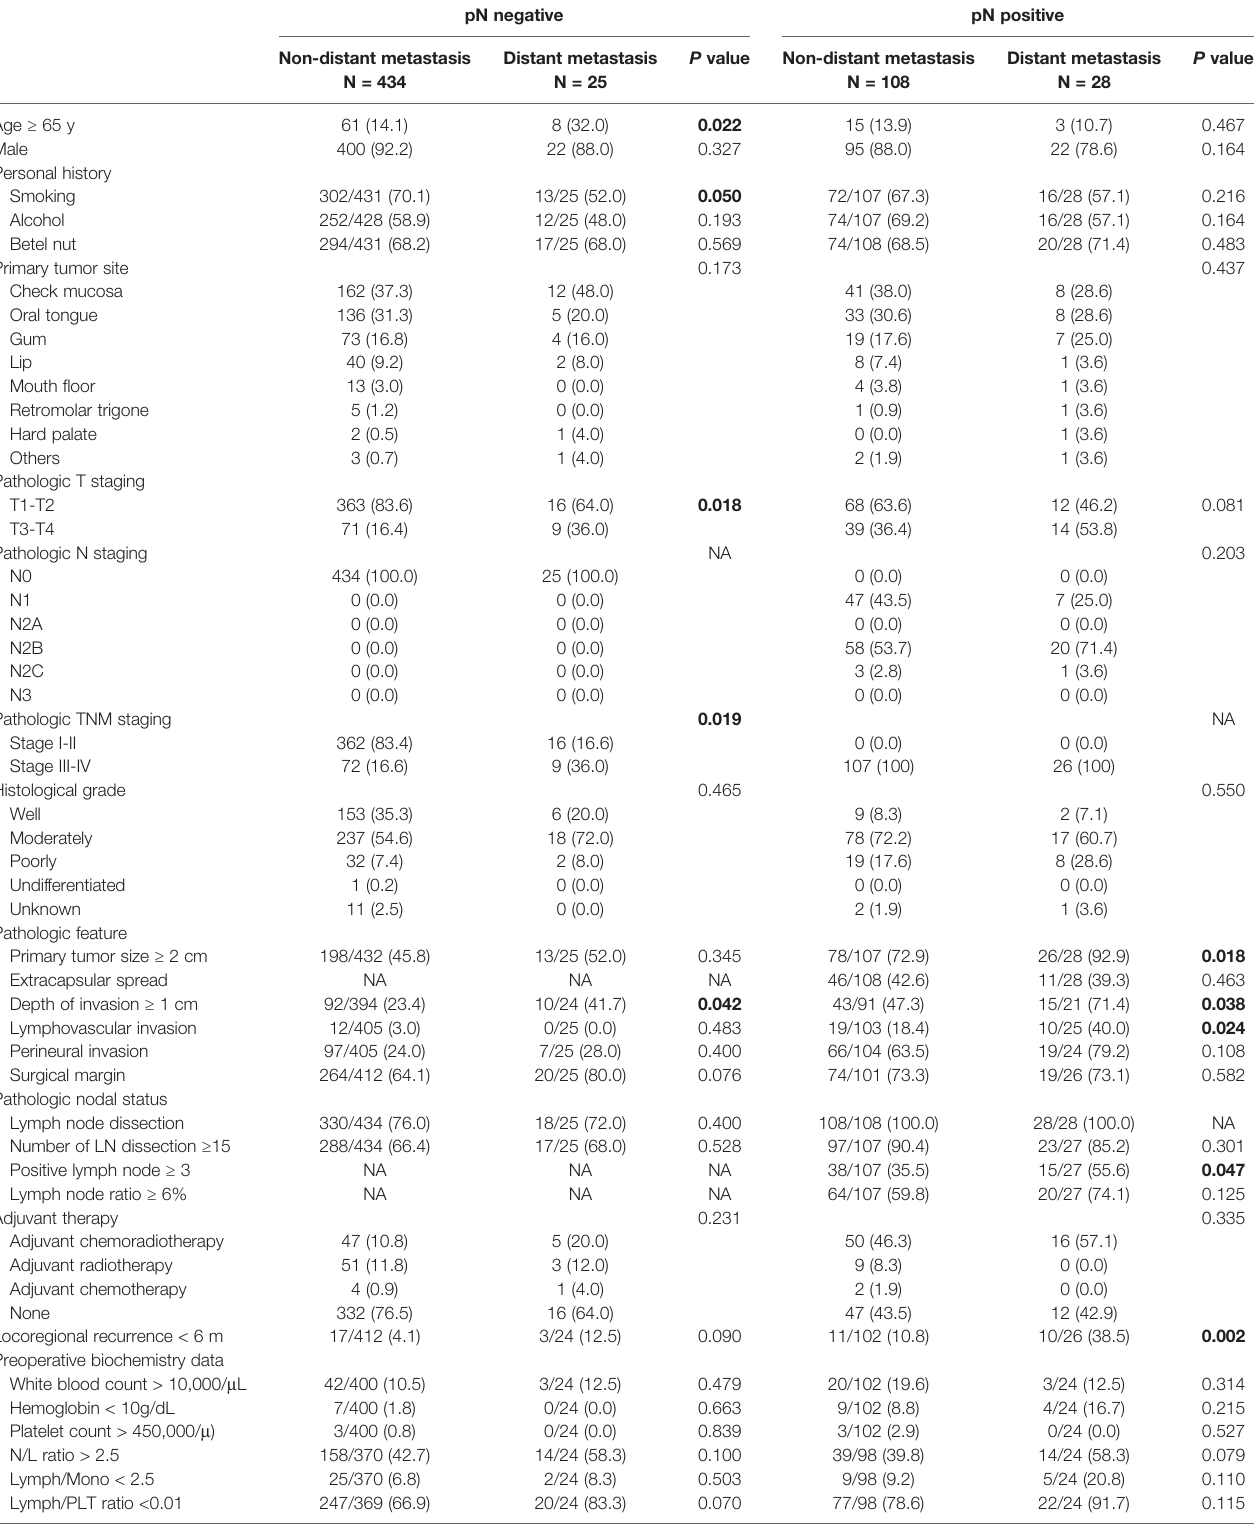
TABLE 1 | Basic characteristics of OCSCC patients with or without distant